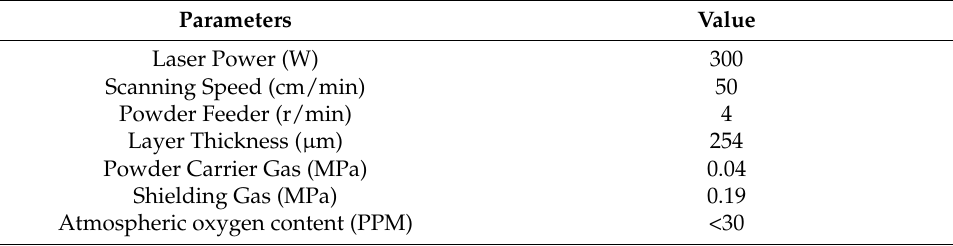
Table 2. Processing parameters of M2052–NAB